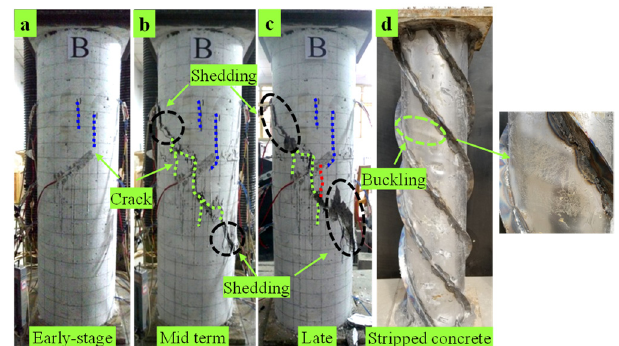
Figure 4. Damage phenomenon of C1. ( a ) Early-stage ( b ) Mid term ( c ) Late. C2 specimen: At the initial stage of loading, several vertical cracks at 200 mm from the upper-end plate are shown in Figure 5a; for continuous loading, the upper cracks extend obliquely to the adjacent surface of the specimen; in the middle stage of loading, the cracks on each surface of the specimen continue to expand along the direction of spiral ribs. When the load reaches 1832.5 kN, the cracks extend to the middle and lower parts of the specimen and the width extends to 5 mm with concrete peeling, as shown in Figure 5b. In the later loading stage, the crack width of each surface of the specimen is up to 20 mm and the concrete falls off along the inclined crack position in the direction of the spiral rib and the failure mode is shown in Figure 5c. As shown in Figure 5d, there is buckling of about 5 mm in the upper part of the steel tube and there is no evident buckling in the remaining parts.